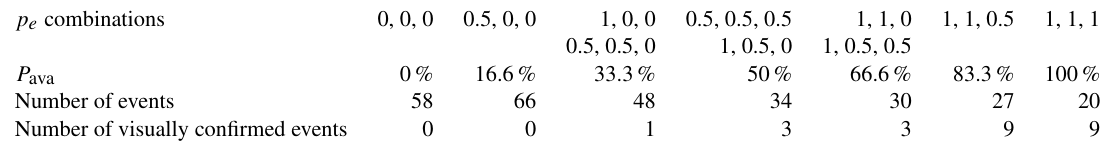
Table 1. Number of events per probability class P ava after re-evaluation and the corresponding number of confirmed events for each class. The first row shows the possible combinations of subjective probability ( p e ): when p e = 1 it was certain that the event was an avalanche; when p e = 0 . 5 it was uncertain; and when p e = 0 it was certain that the event was not an avalanche. p e combinations 0, 0,